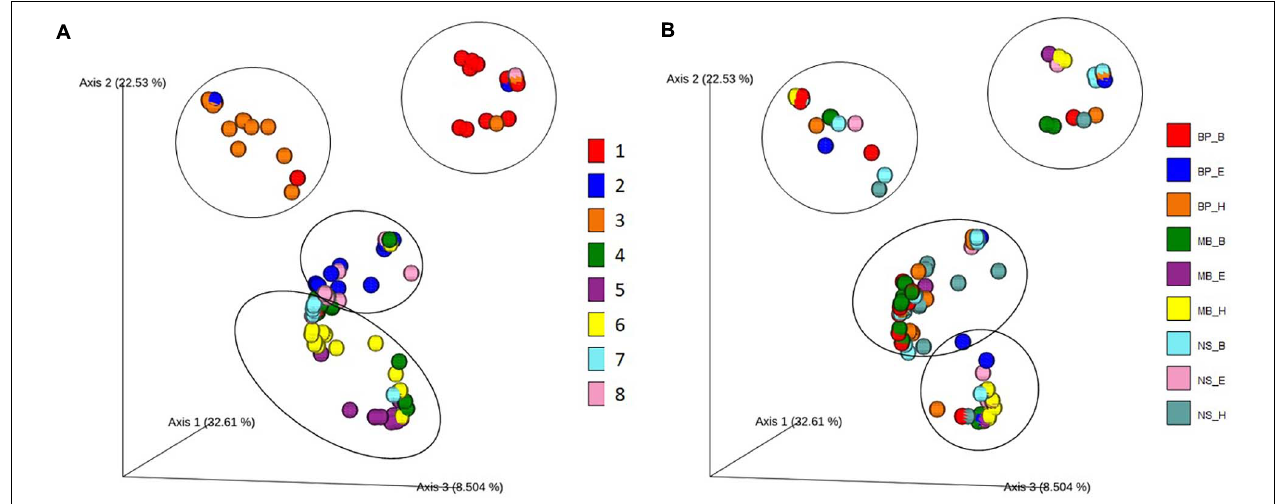
FIGURE 5 | Principal coordinate analysis (PCoA) plot showing the similarities in the bacterial diversity according to the Bray–Curtis distance: (A) among the different sausage samples and (B) among the different DNA extraction protocols. Each of the eight sausages and of the nine DNA extraction protocols is indicated by a unique color; abbreviations for the samples and the protocols are given in Tables 1 , 2 ,